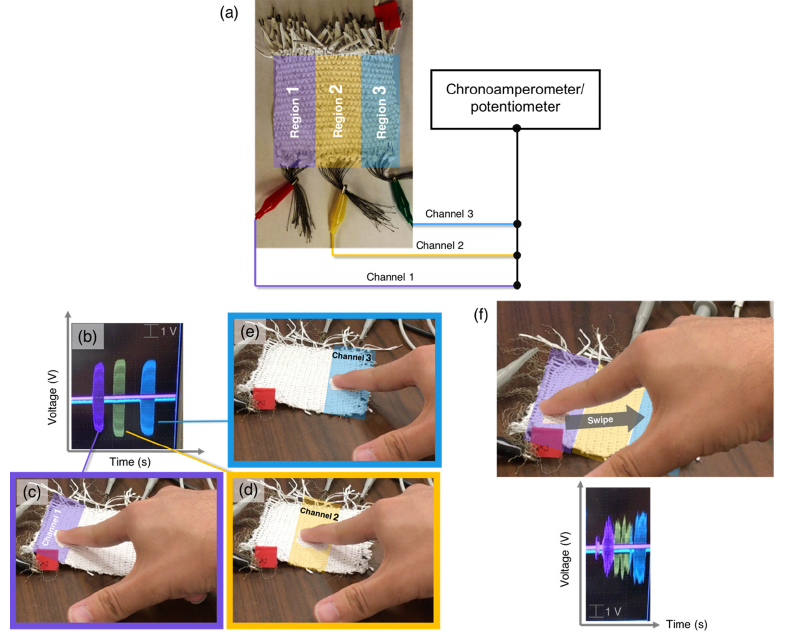
Figure 2. ( a ) Circuit diagram for testing woven textile touch sensors. The conductive threads from each string are bundled and connected to the potentiometer/chronoamperometer, segmenting the device into separate readout channels indicated by the different colored areas. ( b ) Voltage output with a 500 G Ω load resistance from three different sensing channels (purple, yellow, blue) when the corresponding spatial regions of the textile sensor (highlighted) are touched ( c – e ). ( f ) Voltage output with a 500 G Ω load resistance when a finger is swiped across the length of the textile touch sensor.